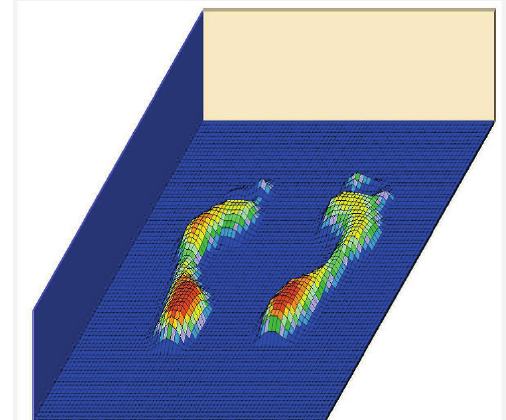
Figure 3 - The measuring result of the peaks of plantar pressure, static measurement, patient barefoot in 3D representation. Color matching to points of less pressure in blue (represented by the parties with mild elevation, base and areas without pressure) and the points with the highest pressure is in red (peak of the